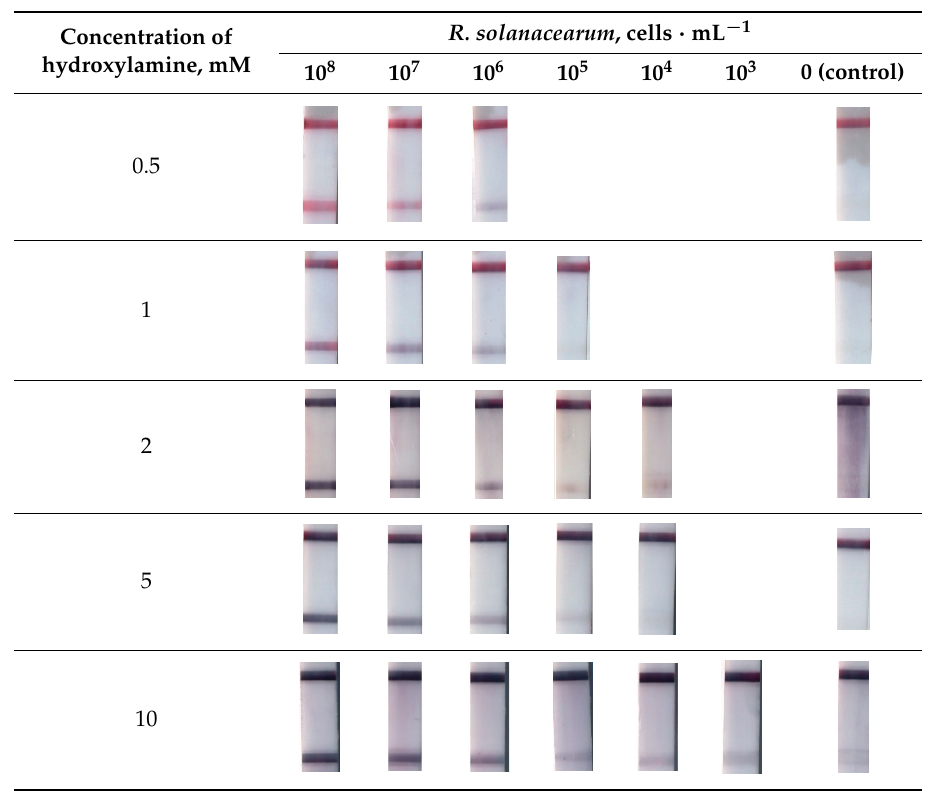
Table 1. Optimization of the hydroxylamine concentration in the enhancement solution: test strips after gold enlargement with different hydroxylamine concentrations.